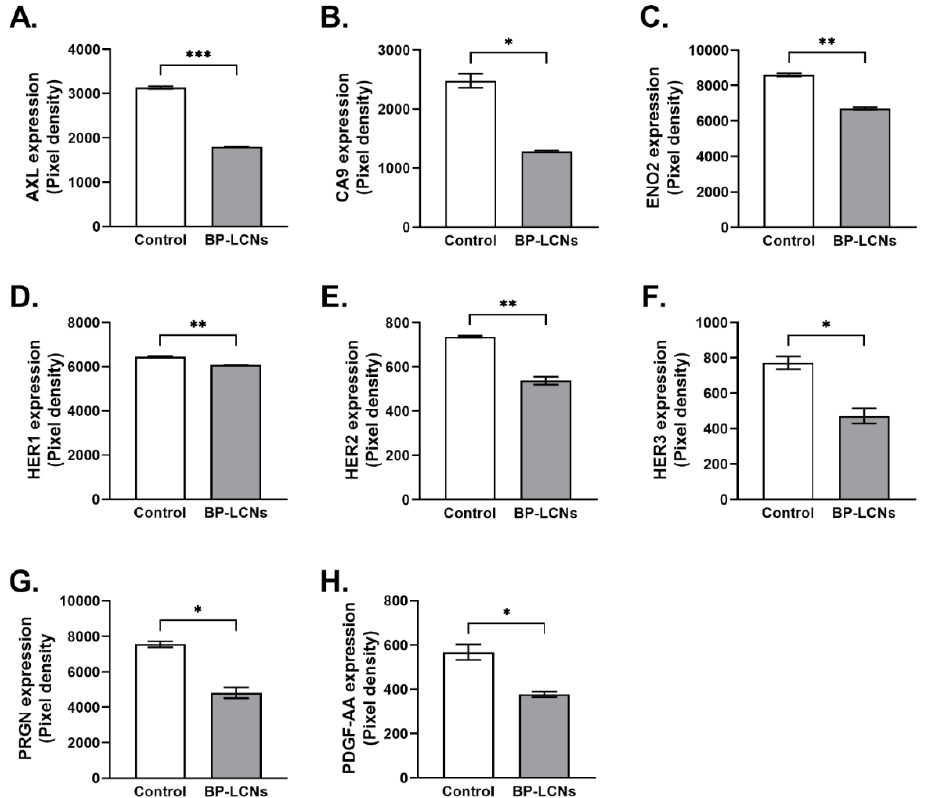
Figure 12. Effects of BP-LCNs on expression levels of proteins related to proliferation in A549 cells. A549 cells were incubated at 37 °C for 24 h in the absence or presence of BP-LCNs (final concentration 5 µM). The figure shows protein expression levels of AXL ( A ), CA9 ( B ), ENO2 ( C ), HER1 ( D ), HER2 ( E ), HER3 ( F ), PRGN ( G ), and PDGF-AA ( H ). The protein expression levels were determined using an oncogene protein array kit and by quantifying the pixel densities of the respective proteins. The values represent means ± SEM of 3 independent experiments. Note: * p < 0.05, ** p < 0.01, *** p < 0.001. Abbreviations: BP-LCNs, berberine–phytantriol liquid crystalline nanoparticles; AXL, AXL receptor tyrosine kinase; CA9, carbonic anhydrase IX; ENO2, enolase 2; HER1, human epidermal growth factor receptor 1; HER2, human epidermal growth factor receptor 2; HER3, human epidermal growth factor receptor 3; PRGN, progranulin; and PDGF-AA, platelet-derived growth factor-AA.